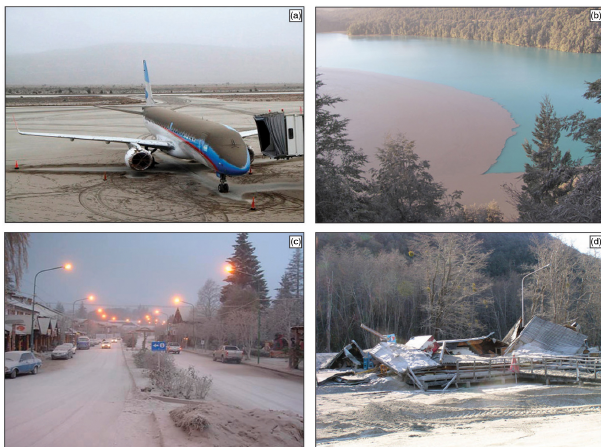
Figure 4. (a) Airplane covered with volcanic ash in Bariloche airport (photo Reuters); (b) Lake Espejo covered with lapilli-size pumice; (c) view of the main street from Villa La Angostura town covered with ash and lapilli, few days after the eruptive climactic phase (Photo Diario de Río Negro, 15 June: http://www.rionegro. com.ar/diario); (d) collapsed tin roof of a restaurant in the area of Paso